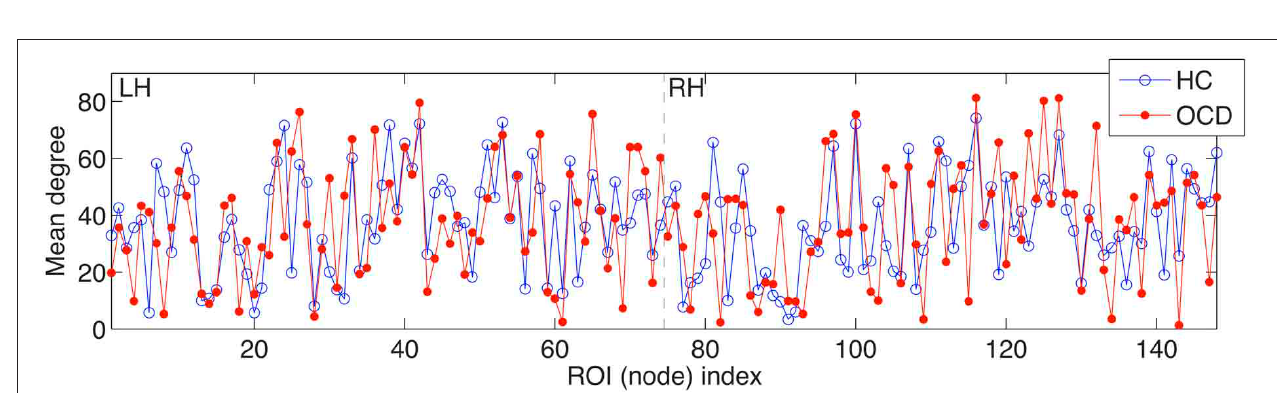
FIGURE 9 | Degree (upper row) and efficiency (lower row) are plotted over cost for the nodes with smaller nodal efficiency (A, cyan) and smaller neighboring efficiency (B, cyan) from OCD patients. For comparison, the measures of the other nodes from the patients with